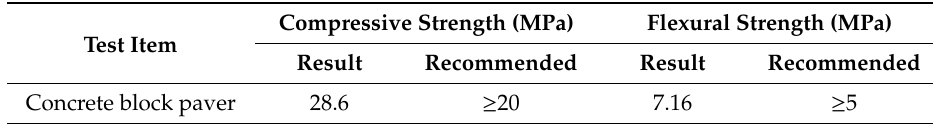
Table 8. The test result of concrete block